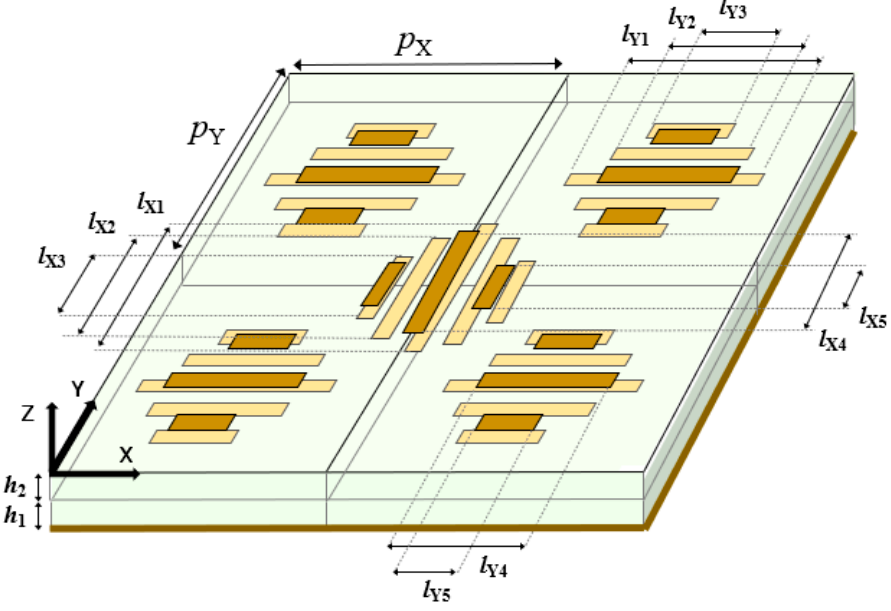
Figure 13. Dual-layer reflectarray cells are formed by orthogonally arranged groups of dipoles, each comprising five dipoles on the bottom dielectric layer and three dipoles on the upper layer.